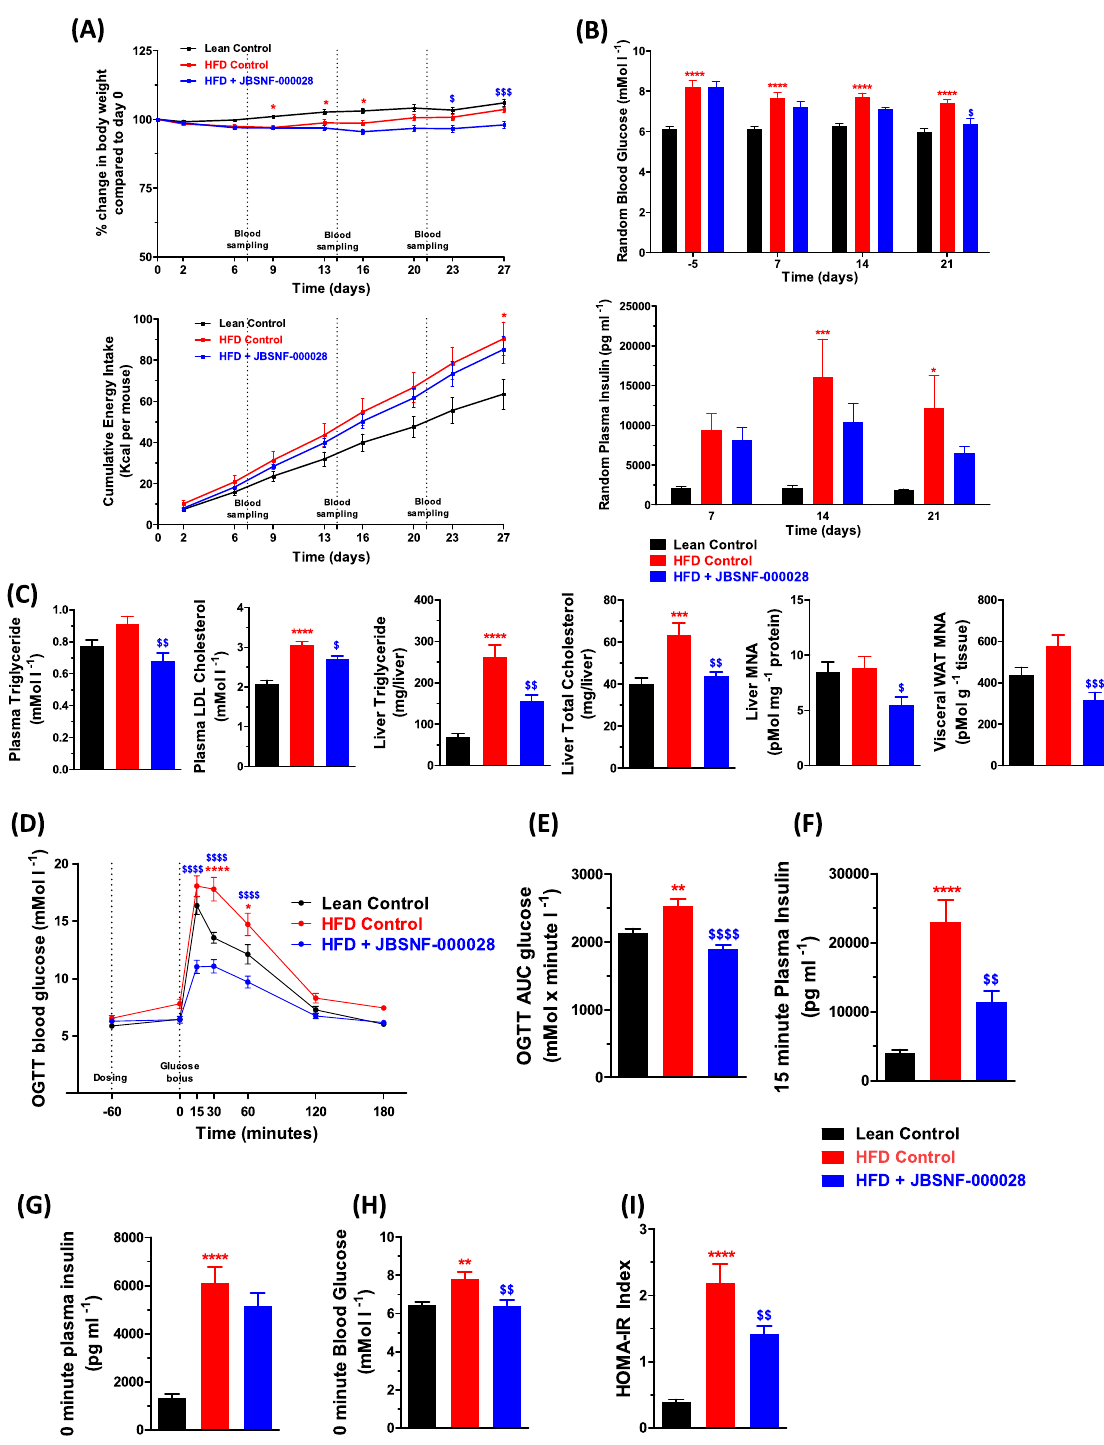
Figure 5. Efficacy of JBSNF-000028 in chronic DIO model. ( A ) Body weight changes (%) and cumulative energy intake in lean control animals and HFD fed animals treated with vehicle or JBSNF-000028 at 50 mg kg −1 . ( B ) Fed blood glucose and fed plasma insulin profile of lean control animals and HFD fed animals treated with vehicle or JBSNF-000028 at 50 mg kg −1 . ( C ) Plasma triglycerides, plasma LDL cholesterol, liver triglycerides, liver total cholesterol, MNA measurements in liver and visceral WAT samples of lean control animals and HFD fed animals treated with vehicle or JBSNF-000028 at 50 mg kg −1 . ( D ) Oral glucose tolerance test (OGTT), ( E ) Area under the curve (AUC) for the OGTT. ( F ) Plasma insulin levels at t = 15 min. ( G ) Plasma insulin and ( H ) plasma glucose concentrations at t = 0 min. ( I ) HOMA-IR index. Data are presented as mean ± s.e.m. * p < 0.05, ** p < 0.01, *** p < 0.0001 and **** p < 0.0001 when compared with lean Control and $ p < 0.05, $$ p < 0.01, $$$ p < 0.001, $$$$ p < 0.0001 when compared with HFD Control. Two way ANOVA followed by Bonferroni’s post-hoc test ( A , B , D ); One way ANOVA followed by Bonferroni’s post-hoc test ( C , E – I